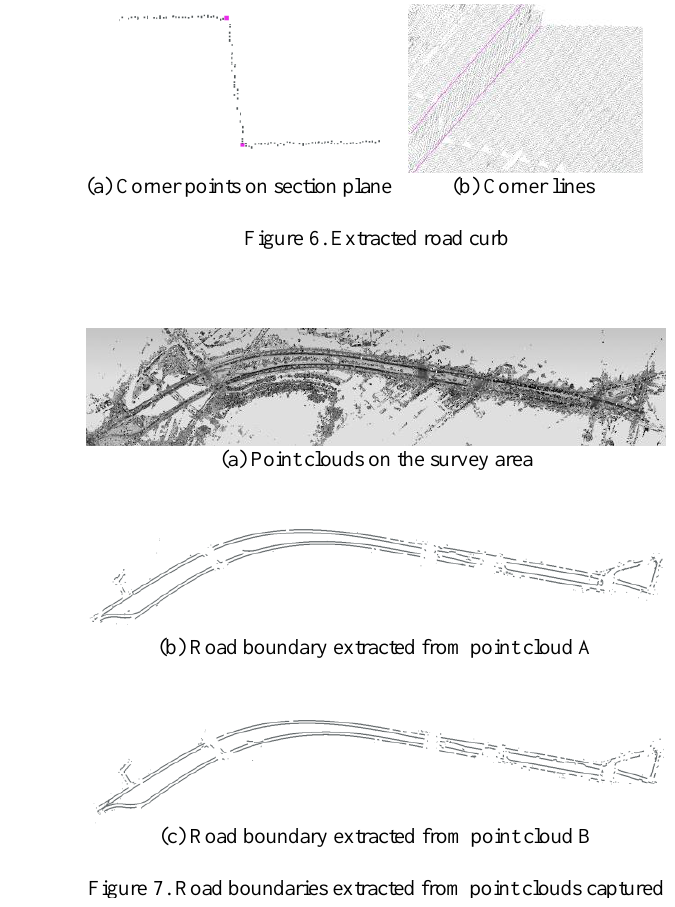
Table 2. Specification of the LIDAR scanner